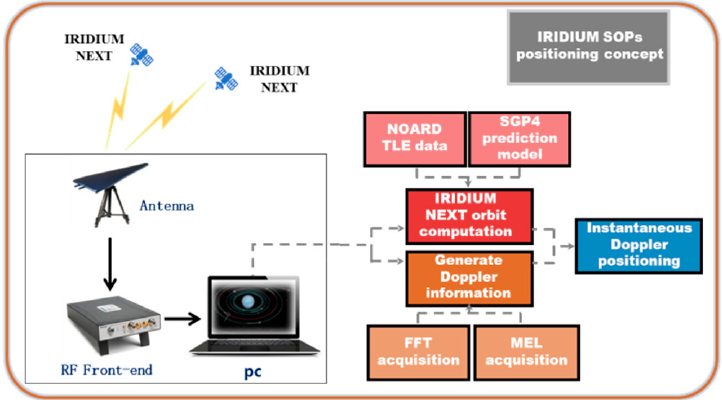
Figure 3. Basic Iridium SOPs positioning principle in weak signal environment.